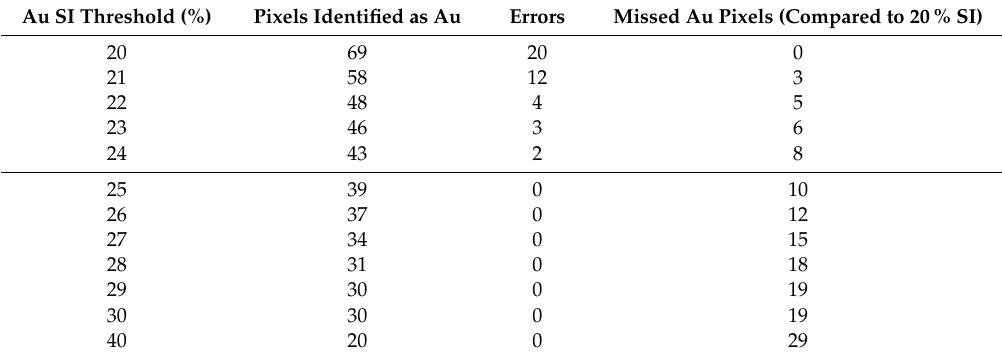
Table 3. A range of Au signal intensity (SI) thresholds, defined in the SIP to identify pixels as Au, and their respective outcome after processing of the Boliden AB QEMSCAN ® analysis. Pixels identified as Au include the